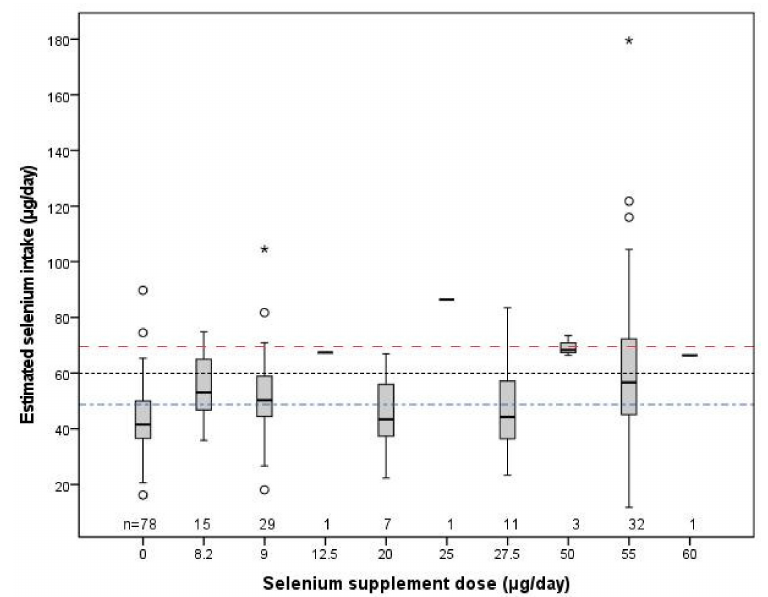
Figure 2. Estimated selenium intake ( µ g/day) of pregnant JOZO participants in relation to the reported selenium supplement dose ( µ g/day). The lower horizontal line (- · - · ) depicts the 49 µ g/day Estimated Average Requirement (EAR) of the IOM, the middle horizontal ( ···· ) line—the 60 µ g/day RDA of the IOM and Nordic, and the upper horizontal line (—-) shows the 70 µ g/day Adequate Intake (AI) of the EFSA, as adopted by the Health Council of the